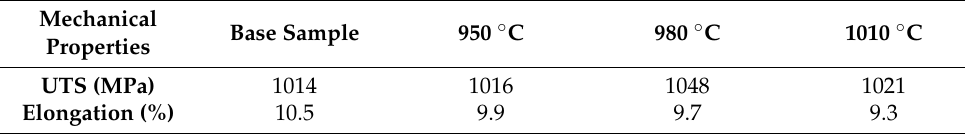
Table 6. Mechanical properties of samples at di ff erent conditions.